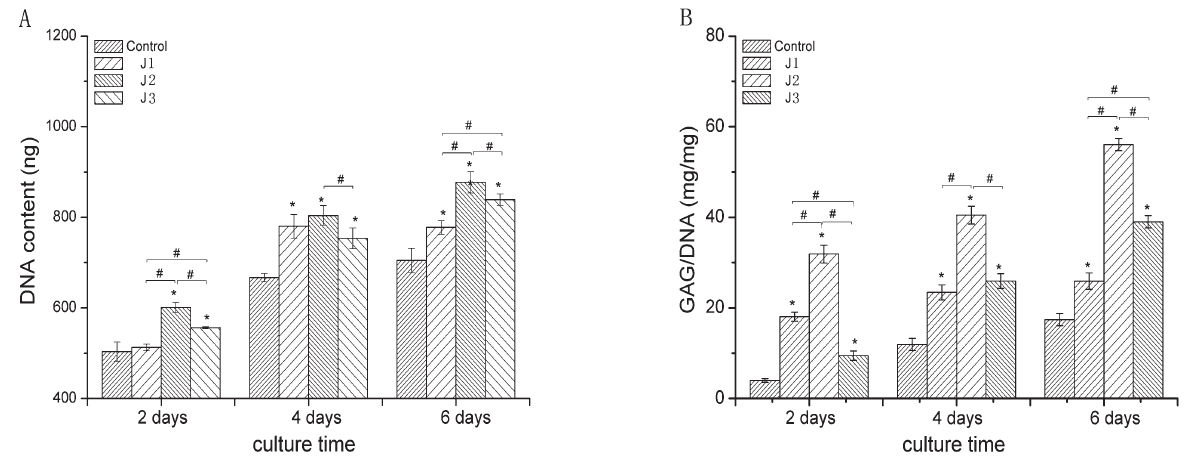
Figure 3. Quantification of cell proliferation by detection of DNA content and matrix production by glycosaminoglycan (GAG) analysis. A , Proliferation of chondrocytes cultured in vitro with 0 (control), 0.125 (J1), 0.25 (J2), and 0.5 m g/mL (J3) JJYMD-C for 2, 4, and 6 days. B , GAG level (mg) normalized to DNA content (mg). Data are reported as means±SD for 4 independent experiments *P , 0.05 compared to control; # P , 0.05 comparisons as indicated (one-way ANOVA followed by the Dunnett post hoc